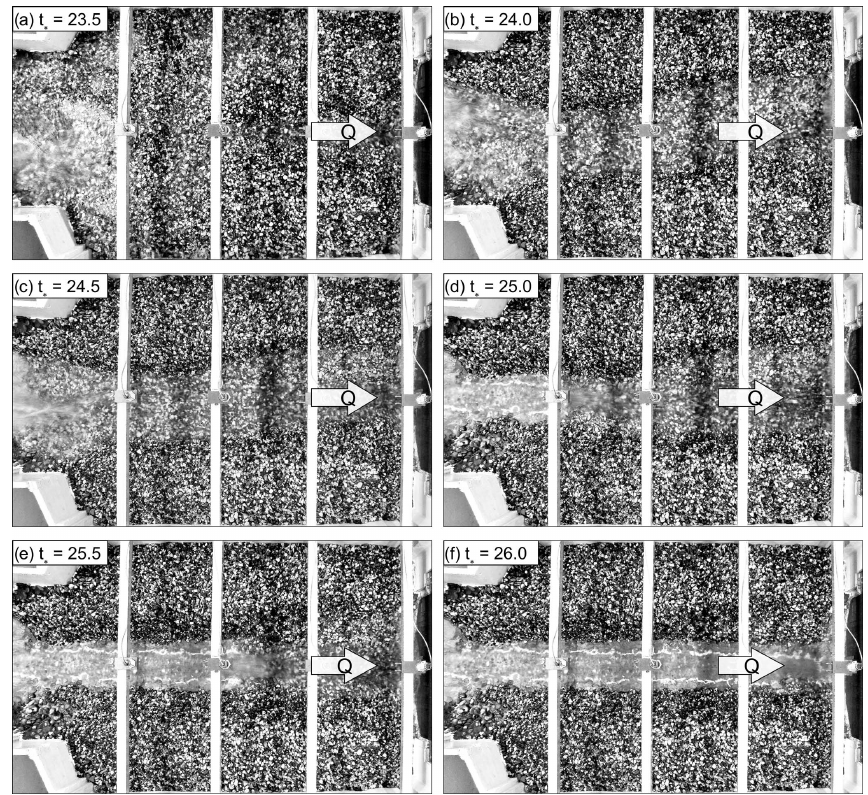
Figure 13. Controlled flushing of the guiding channel after the hydrograph test Hy-no β , in time lapses of 0 . 5 · t ∗ , starting from t ∗ = 23 . 5, after creating gradually an artificial depression above the guiding channel, until t ∗ = 26 . 0, where the guiding channel was completely